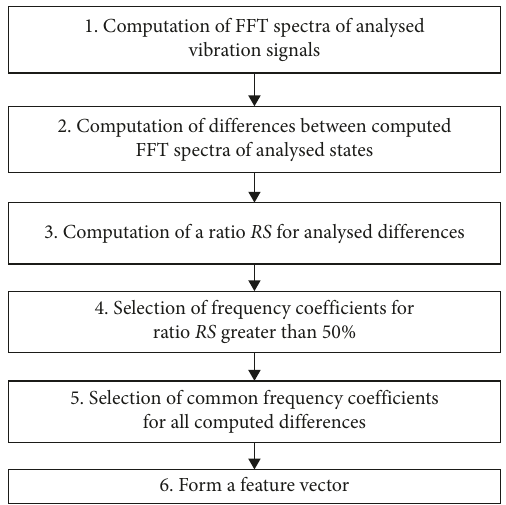
Figure 5: Flow diagram of the MSAF-RATIO-50-SFC.